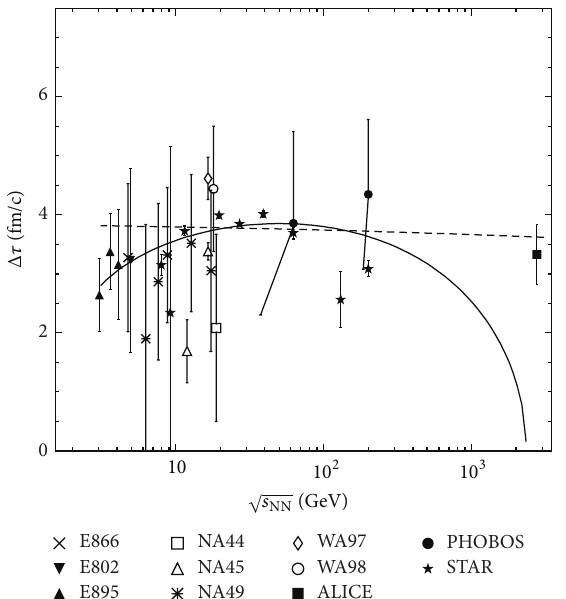
Figure 2: Energy dependence of emission duration for secondary chargedpionsincentralheavyioncollisionsAu + Au,Au + Pb,Pb + Pb in midrapidity region and at ⟨𝑘 ⊥ ⟩ ≃ 0.2 GeV/ 𝑐 . Experimental results are shown for the same particle types and Coulomb corrections as well as in Figure 1. Error bars are only statistical (for NA44, total uncertainties). Smooth curves are derived from(5) and the fit results for 𝑅 𝑠 , 𝑅 𝑜 without the point of the WA97 experiment [11]. The solid line corresponds to the fits of HBT radii by function (7) and dashed line to the fits by specific case 𝑅 𝑖 ∝ ln 𝜀 , 𝑖 = 𝑠, 𝑜 .